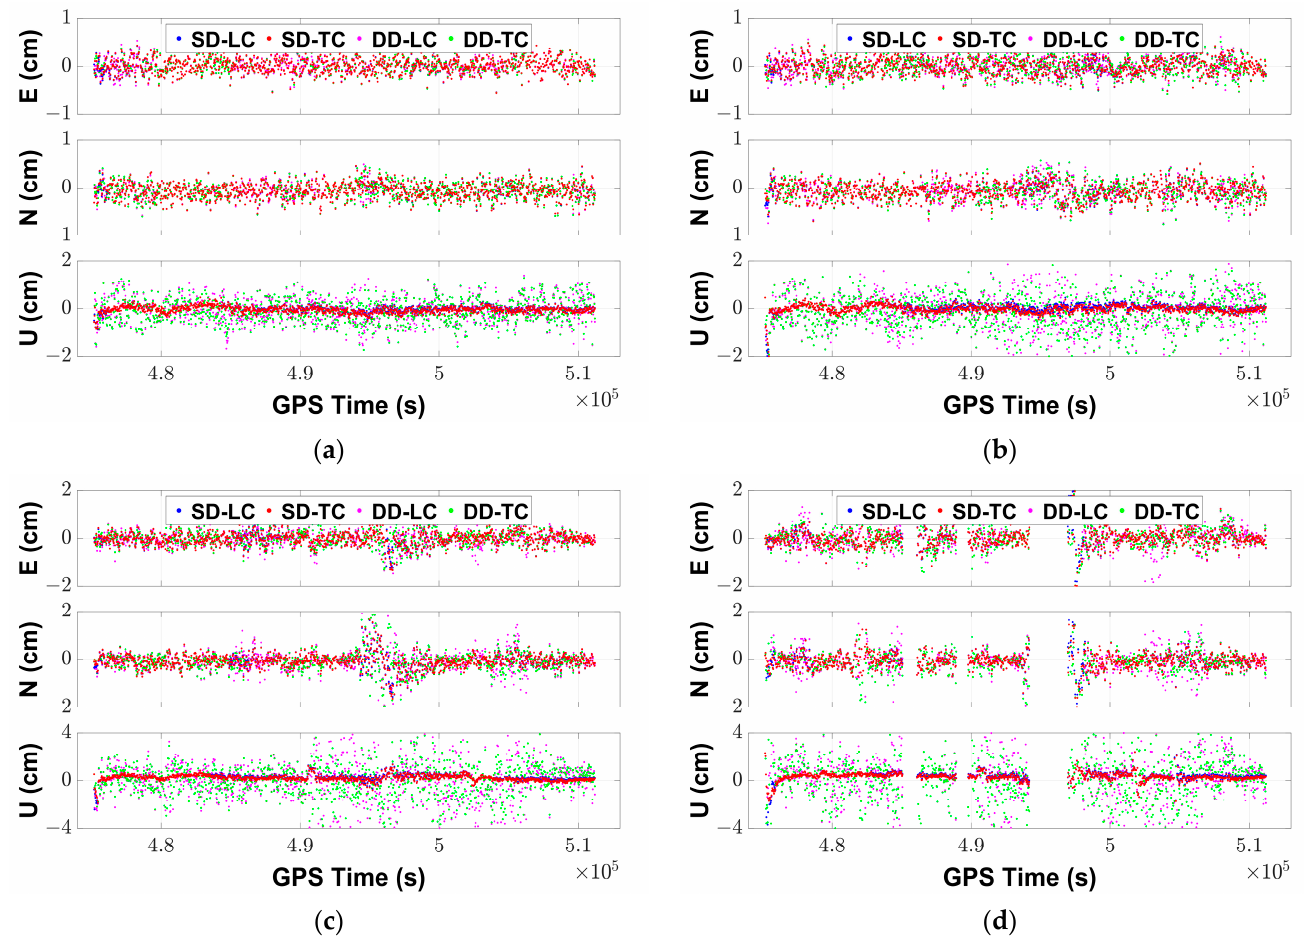
Figure 7. The positioning error series of the DD-LC, DD-TC, SD-LC, and SD-TC models under different elevation cutoff angles in the multi-epoch solution: ( a ) 20°; ( b ) 30°; ( c ) 40°; and ( d ) 45°.